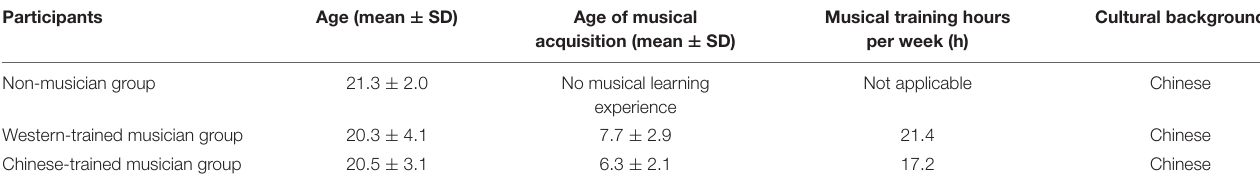
TABLE 1 | Characteristics of the